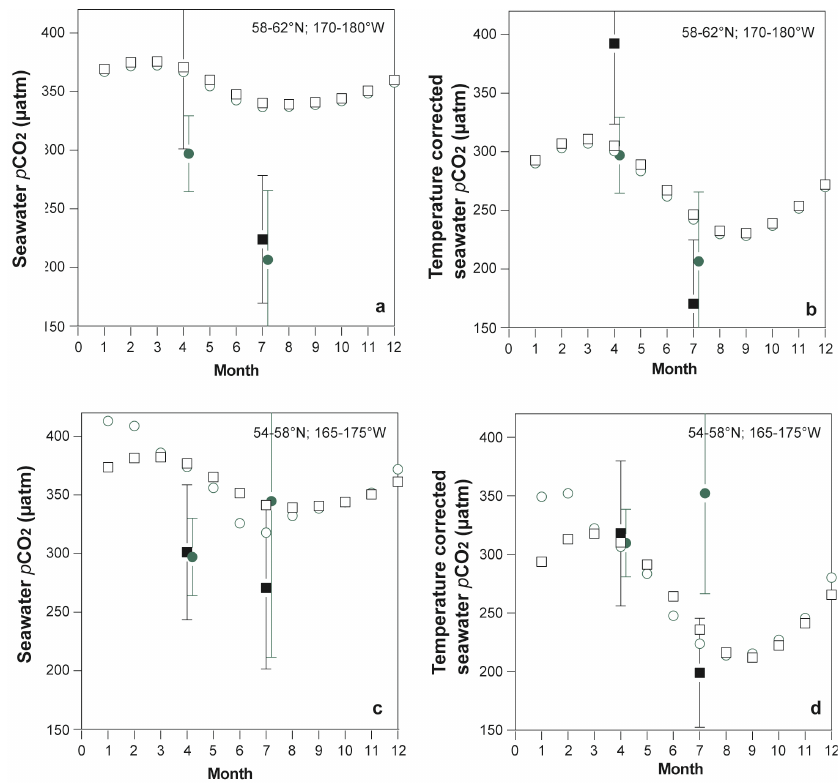
Figure 12 . Comparison of Takahashi et al . (2009) surface seawater p CO 2 and temperature corrected seawater p CO 2 climatology for the Bering Sea shelf with observations from the 2008 BEST spring and summer cruises. The Takahashi et al. (2009) data have a spatial resolution of 4 ◦ × 5 ◦ and monthly resolution. 2008 BEST spring and summer are binned and averaged within each of four Takahashi et al. (2009) 4 ◦ × 5 ◦ that are defined for the Bering Sea shelf. Please note that the mean values for observed data from the two 4 ◦ × 5 ◦ areas have been slightly offset in time to allow for easier interpretation of data. ( a ) surface seawater p CO 2 for the 58 ◦ N–62 ◦ N/170 ◦ W–175 ◦ W (black symbols), and 58 ◦ N–62 ◦ N/175 ◦ W–180 ◦ W (green symbols) areas. In each of the panels, Tahahashi et al. (2009) climatology data are shown by open symbols while 2008 BEST spring and summer are shown as closed symbols (mean and 1 std deviation); ( b ) surface temperature corrected seawater p CO 2 for the 58 ◦ N–62 ◦ N/170 ◦ W–175 ◦ W (black symbols), and 58 ◦ N–62 ◦ N/175 ◦ W–180 ◦ W (green symbols) areas; ( c ) surface seawater p CO 2 for the 54 ◦ N–58 ◦ N/165 ◦ W–170 ◦ W (black symbols), and 54 ◦ N–58 ◦ N/170 ◦ W–175 ◦ W (green symbols) areas; and; ( d ) surface temperature corrected seawater p CO 2 for the 54 ◦ N–58 ◦ N/165 ◦ W–170 ◦ W (black symbols), and 54 ◦ N–58 ◦ N/170 ◦ W–175 ◦ W (green symbols) areas. For the temperature corrected seawater p CO 2 datasets, both Takahashi et al. (2009) and 2008 BEST spring and summer data were corrected to 0 ◦ C using the empirical relationships of Takahashi et al. (2002).